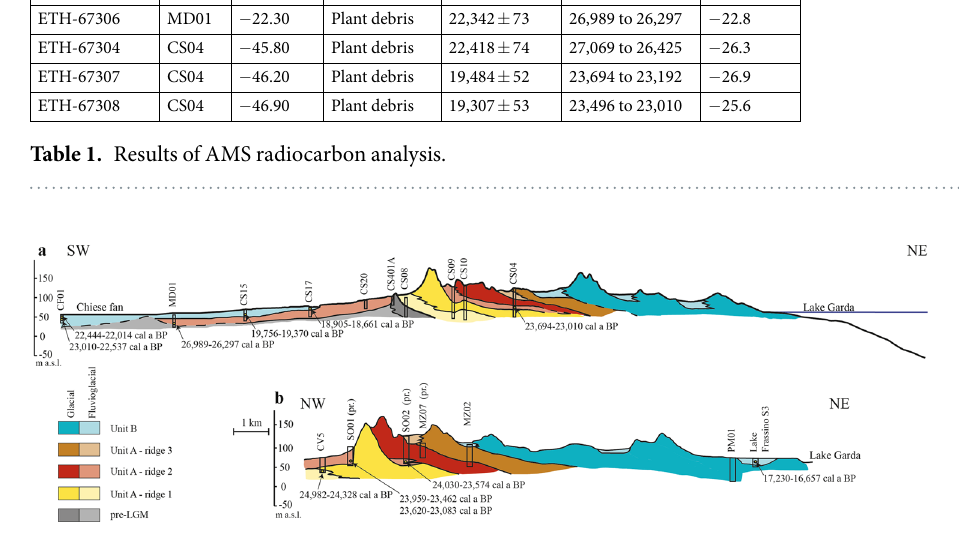
Figure 2. Cross-section of the Garda end-moraine system showing the stratigraphic architecture of the units related to the LGM glaciation; the labelled drillings (rectangle) and related dates (yellow spot) are referred to Table 1; the trace of the profiles is reported in Fig.